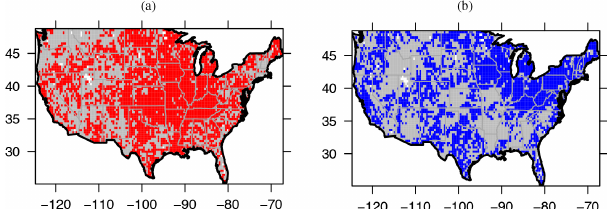
Figure 5. (a) Grids in red show areas whose short-term VIC in warm season data has the same underlying beta distribution as the long-term VIC in warm season data ( n = 3560 or 68% of grids are red); (b) the same as panel (a) , but for cold season period shown in blue ( n = 2927 or 57% of grids). Gray areas are grids where the short-term VIC does not have the same beta distribution as their long-term